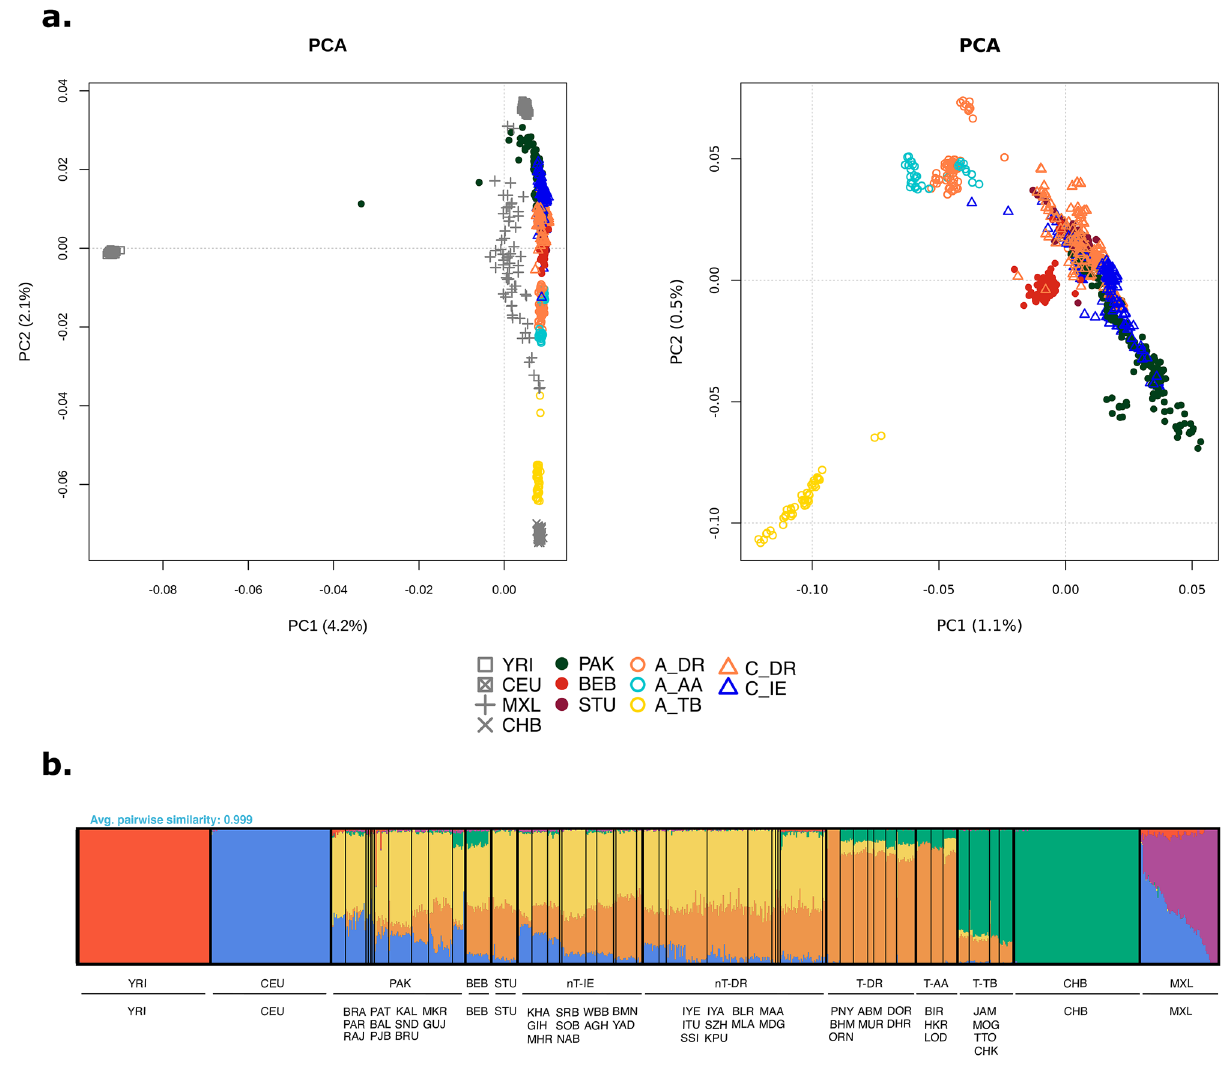
Figure 1. Population structure analysis of the South Asian dataset. ( a ) Principal Component Analysis (PCA) of the curated dataset with (left) and without (right) external reference populations. ( b ) ADMIXTURE analysis of the curated dataset, K = 6 (CV error = 0.4274). For populations from the 1000 GP belonging to the South Asian region, a subset of 15 samples is represented. Population group abbreviations: T-AA tribal